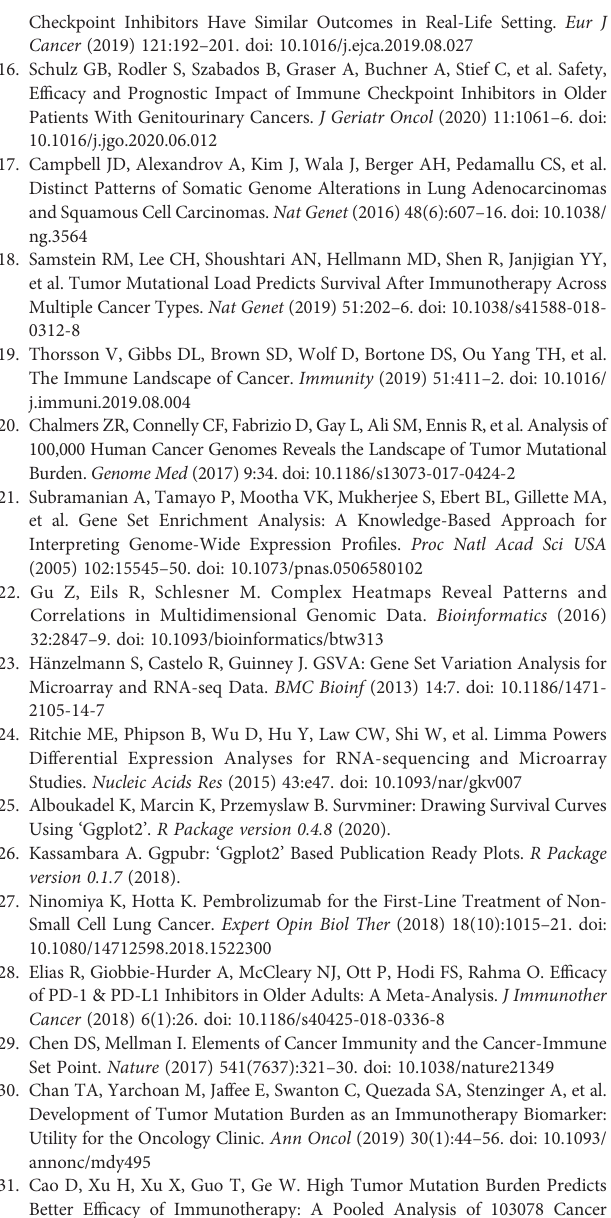
Supplementary Figure 1 | Kaplan-Meier curves depicting overall survival (OS; in months) according to different age cutoff points in patients receiving PD-1/PD-L1 inhibitors (the PD-1/PD-L1 group). Supplementary Figure 2 | Kaplan-Meier curves depicting overall survival (OS; in months) according to different age cutoff points in patients receiving CTLA-4 inhibitors (the CTLA-4 group). Supplementary Figure 3 | Kaplan-Meier curves depicting overall survival (OS; in months) according to different age cutoff points in patients receiving a combination of PD-1/PD-L1 inhibitors and CTLA4 inhibitors (the combo group). Supplementary Figure 4 | Differences in gene expression between the elderly group ( ≥ 50 years old) and the young group of pan-cancer patients in The Cancer